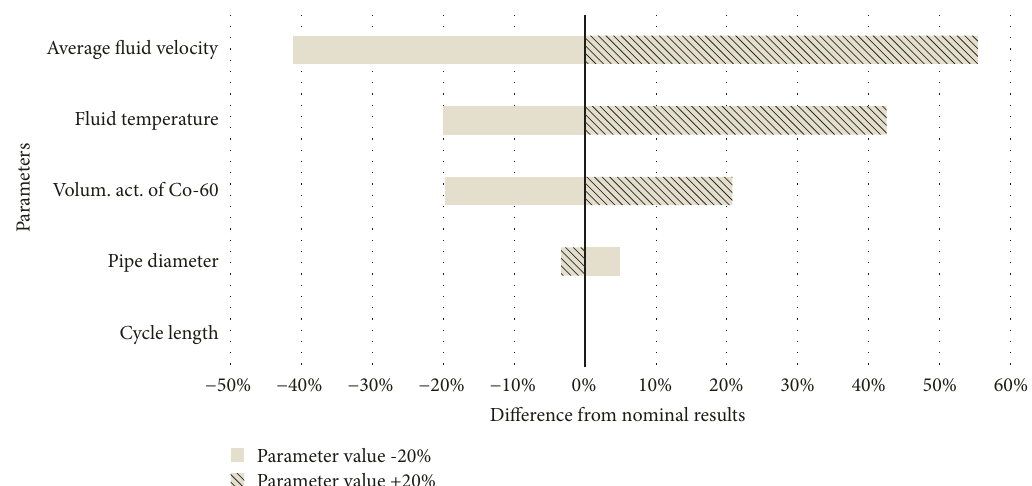
Figure 8: A tornado diagram presenting results of the sensitivity analysis of SP-HPR-4 component’s contamination with